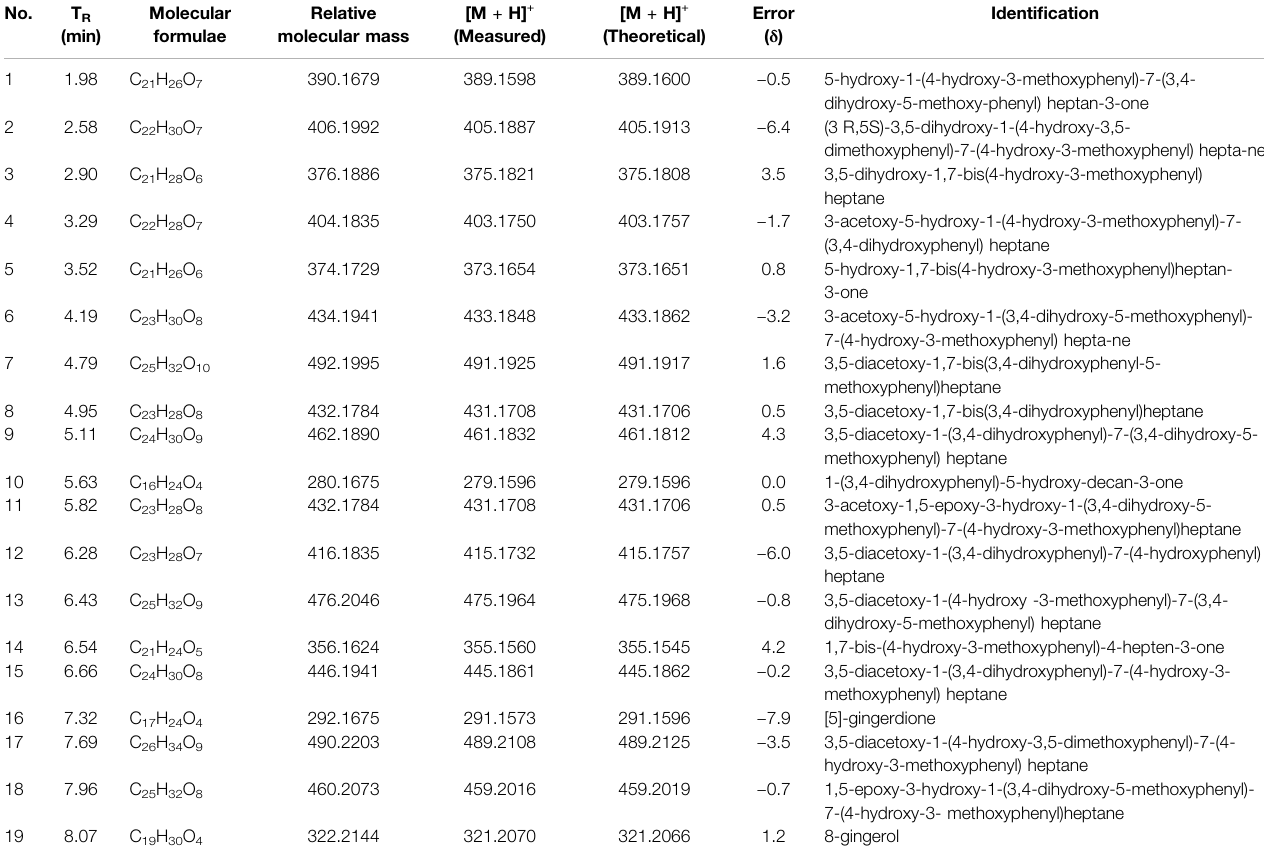
TABLE 2 | Identi fi cation of chemical constituents of Ganjiang by UPLC-Q-TOF/MS E